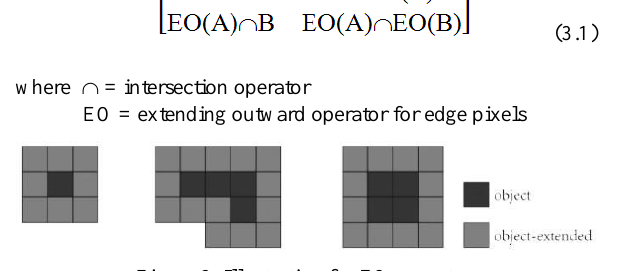
Figure 3. Illustration for EO